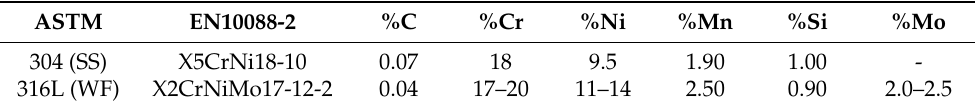
Table 1. Composition of stainless steel (SS) and welding filler (WF).